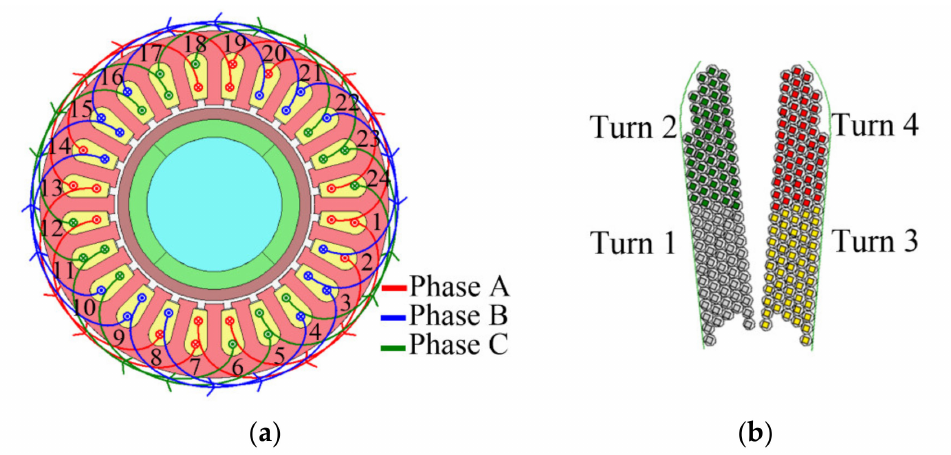
Figure 2. AC copper loss analysis model. ( a ) Overall model. ( b ) Conductor models per